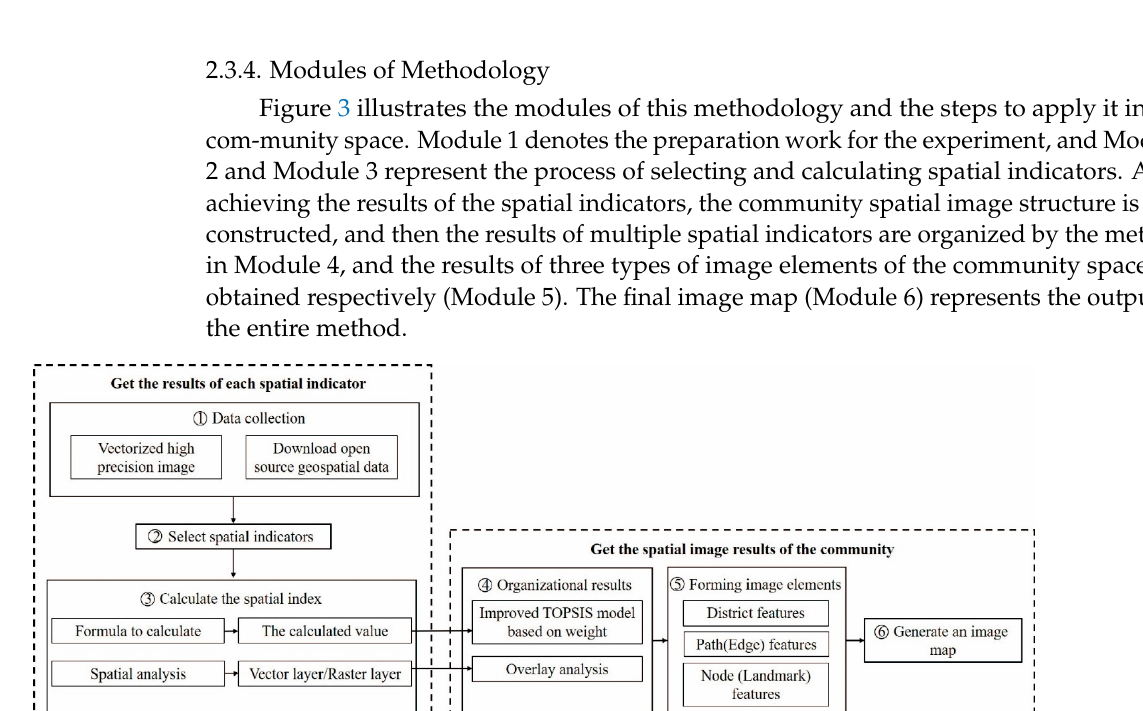
Figure 4. Calculation results of spatial indicator in the Jinghu Community: ( a ) plot ratio; ( b ) shape index .